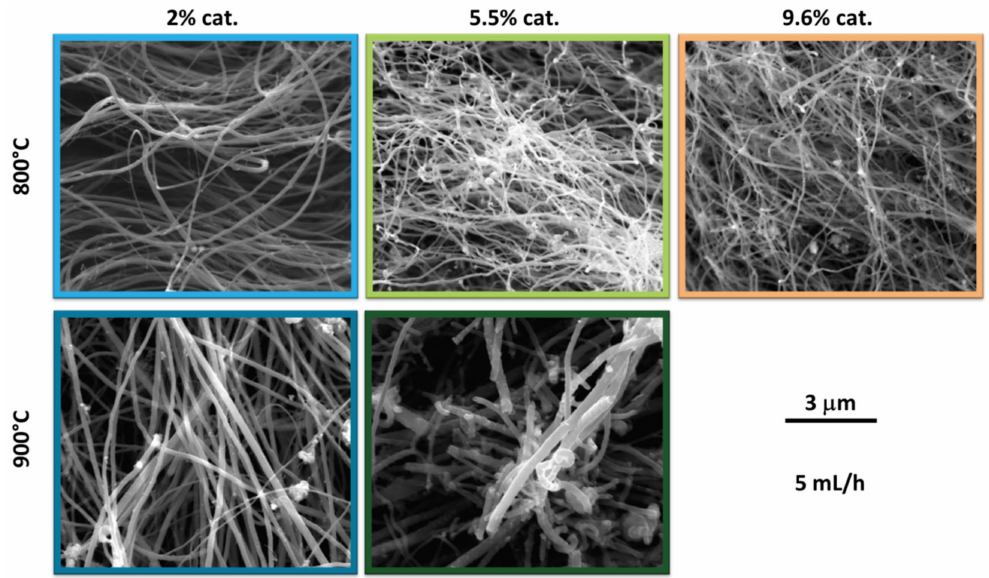
Figure 4. Scanning electron microscopy (SEM) micrographs of CNTs obtained at 800 ◦ C (first row) or 900 ◦ C (second row) with di ff erent amount of catalyst: 2% cat. (first column), 5.5% cat. (second column), or 9.6% (third column).